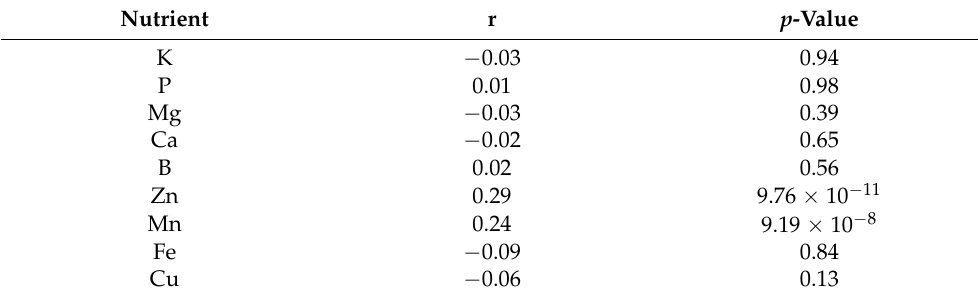
Table 3. Corresponding p -values and r values (Pearson’s coefficient) of correlations examined between soil nutrient concentrations and foliar fertilizer treatments from all time points of sampling, which